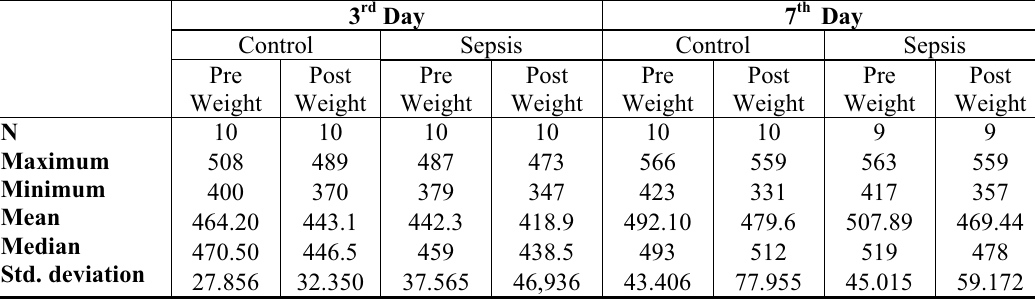
TABLE 1 - Weight in grams in the preoperative period (pre weight) and postoperative (post weight)